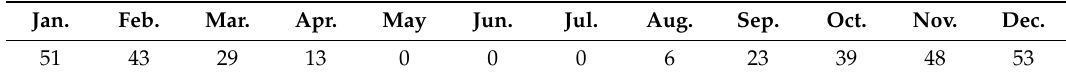
Table 1. The Monthly Tilt angle for Majmaah City